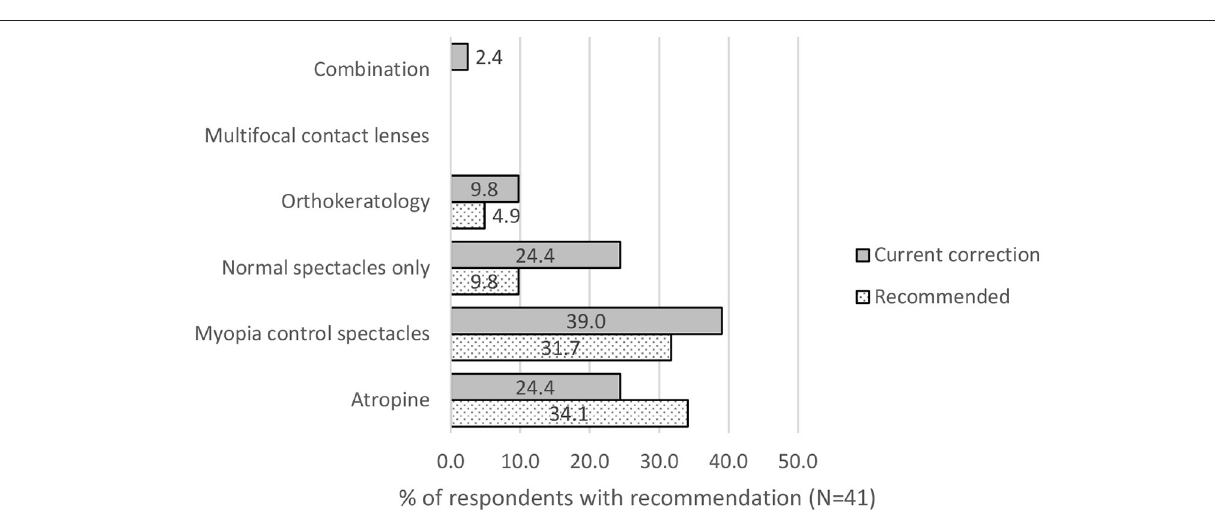
FIGURE 2 | Out of those parents recommended to use myopia control, which product was most recommended (grey bars) by eye care professionals and used (dotted bars) by